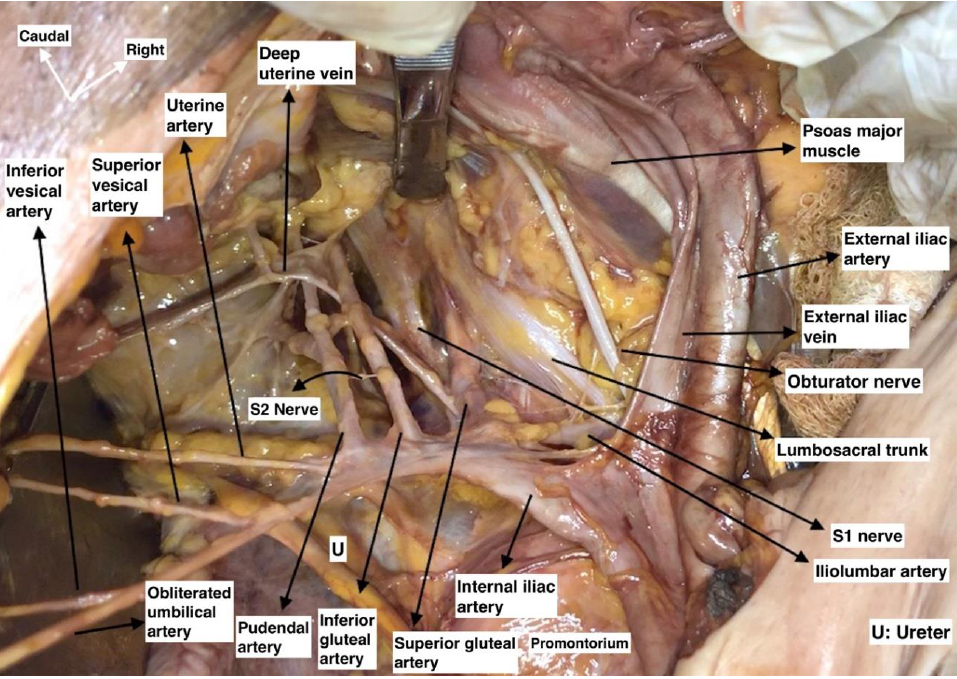
Figure 9. Access to the nerve region at the right pelvic sidewall (cadaveric dissection by Dr. Ilker Selcuk).